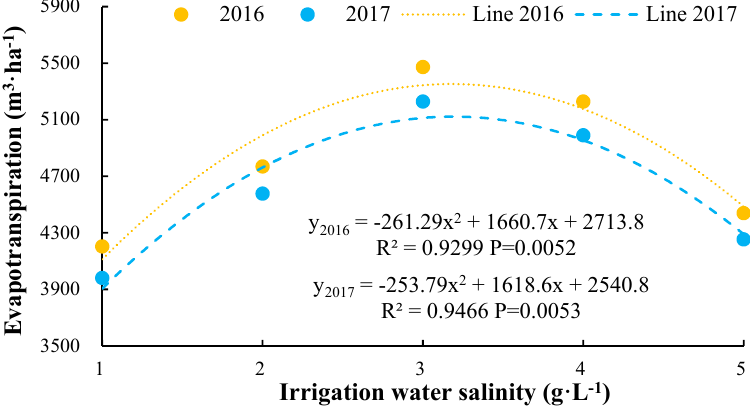
Figure 4. Evapotranspiration for different levels of irrigation water salinity.